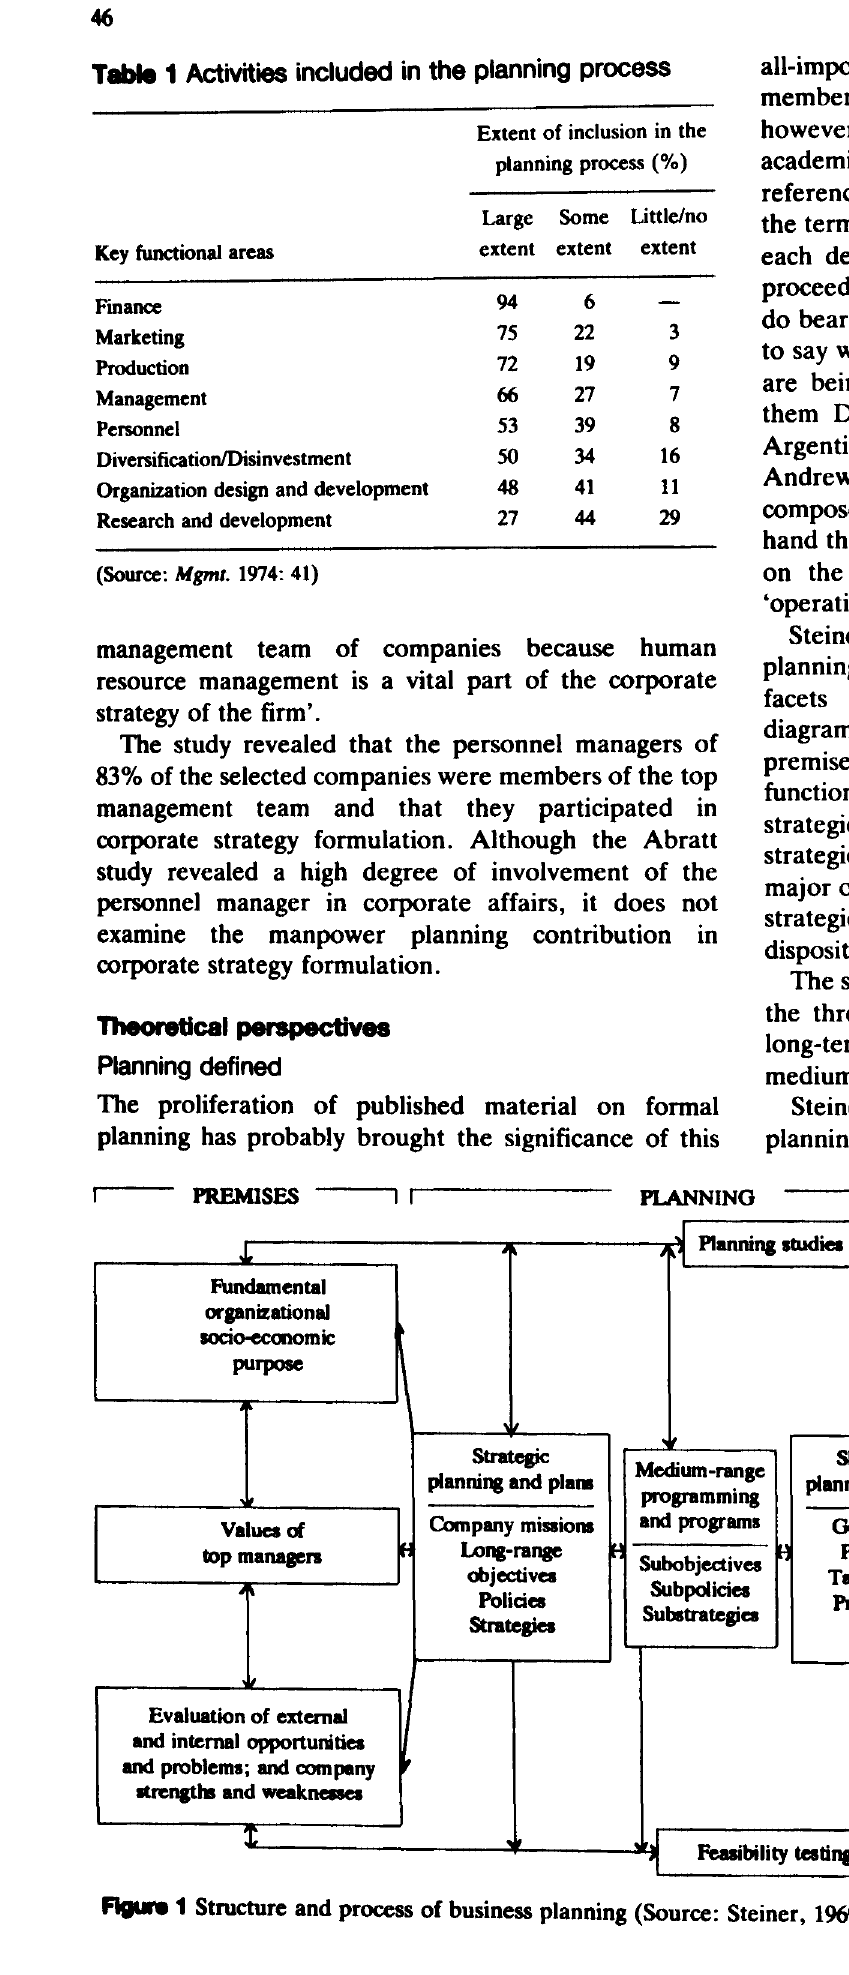
Figure 1 Structure and process of business planning (Source: Steiner, 1969: